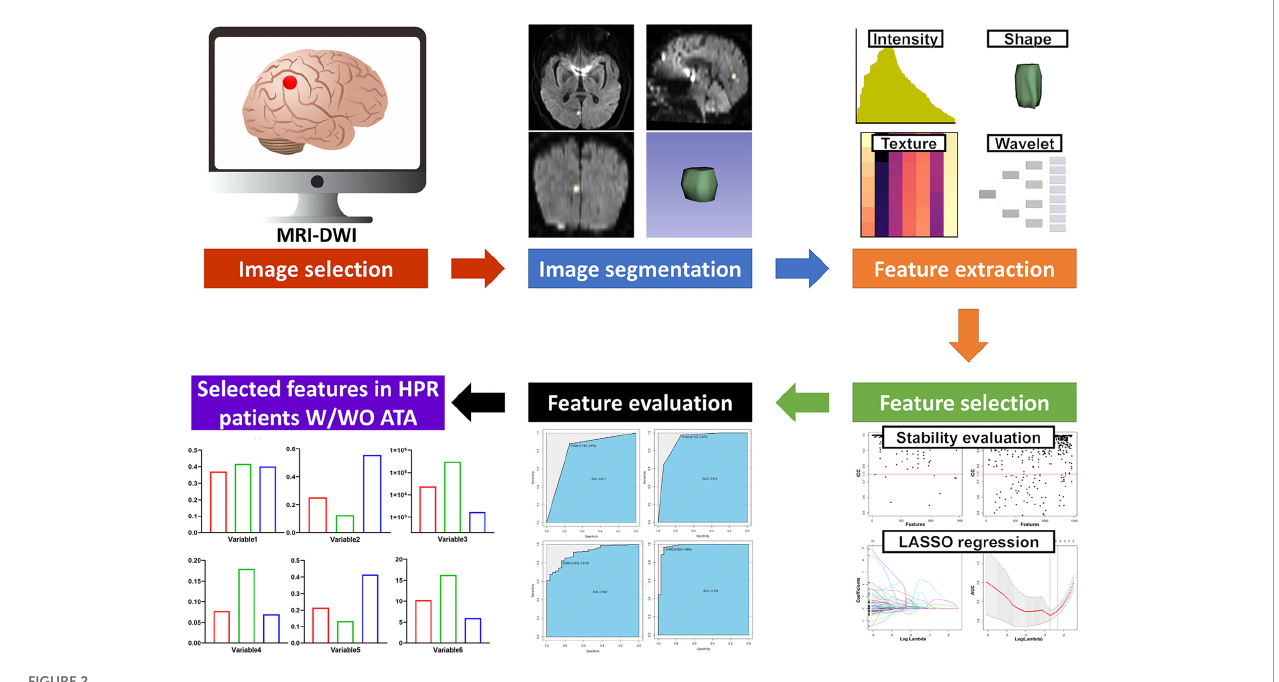
FIGURE2 The radiomics workflow of the